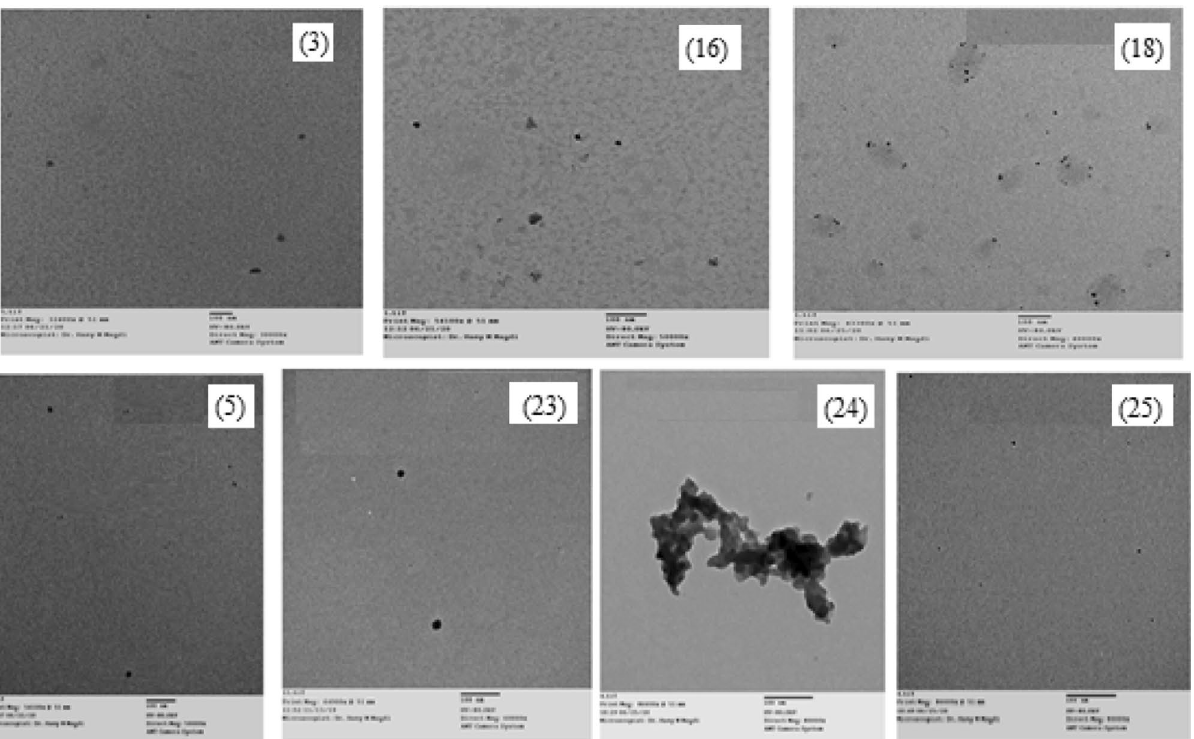
Figure 7. TME images of the nano Co(II) complexes 3, 16, 18 and the nano Cu(II) complexes 5, 23, 24, 25.